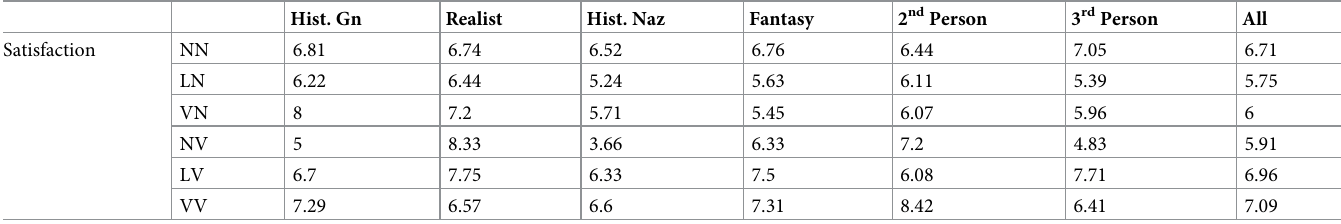
Table 3. Satisfaction by choice path and genre (N =